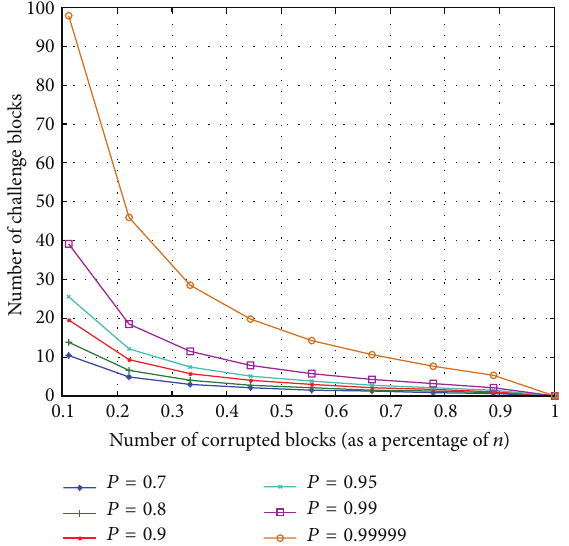
Figure 6: Number or required blocks as a challenge message under different number of data corruptions.